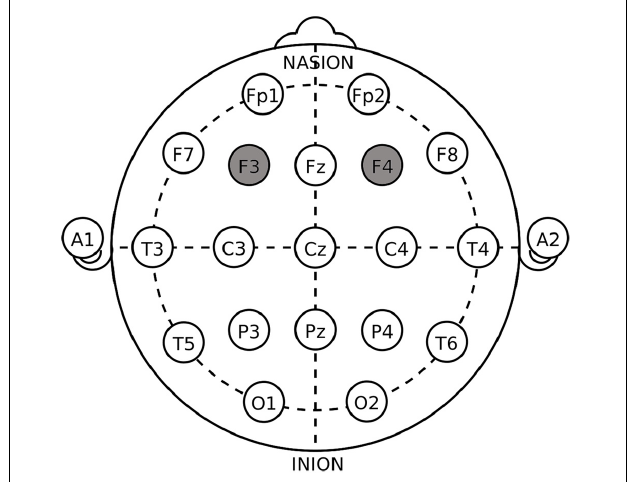
FIGURE 2 | Electrode placement in dorsolateral prefrontal cortex (DLPFC)